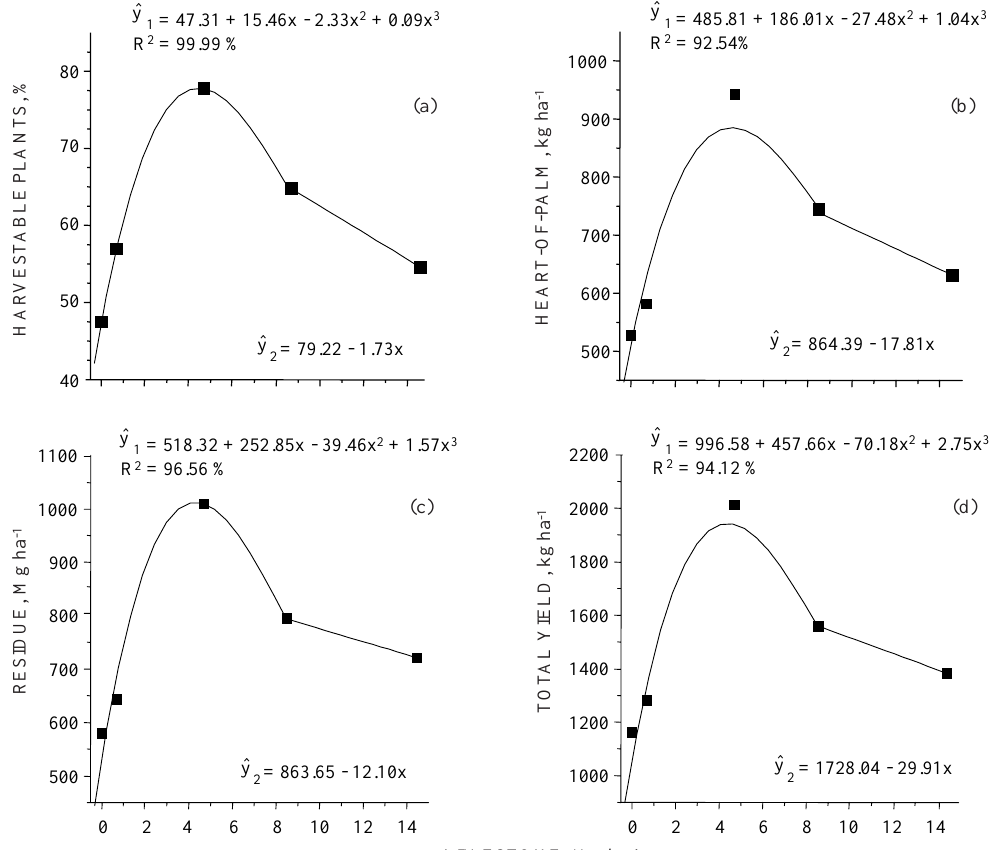
Figure 2. Mean yield of peach palm plants submitted to five liming rates, evaluated for percentage of harvestable plants (a), palm heart weight (b), residue weight (c), and total yield (d). Bars represent the standard deviation. Pariquera-Açu, São Paulo,